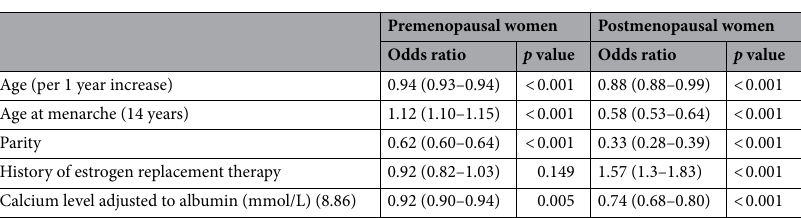
Table 2. Association between known factors that influence breast density and higher mammographic density by menopausal